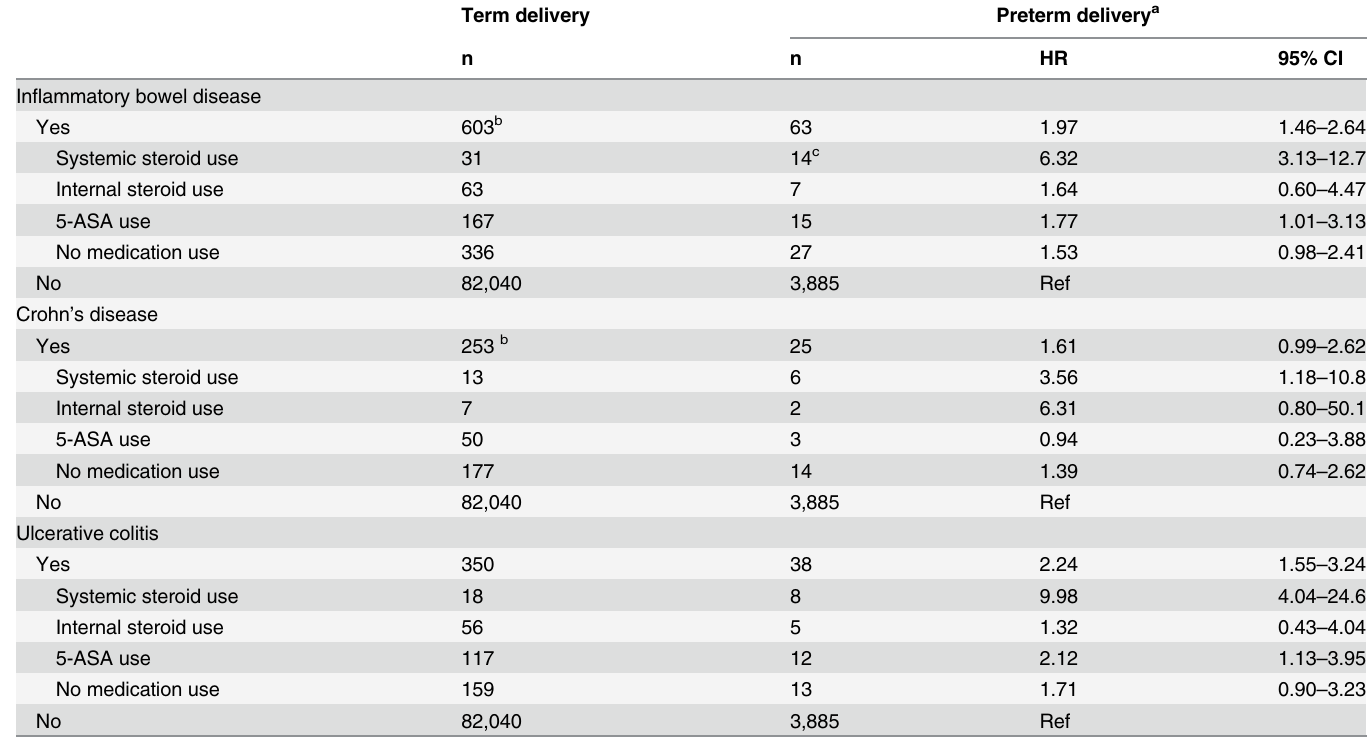
Table 2. Associations between inflammatory bowel disease, medication use during pregnancy and overall rates of preterm delivery in the Danish National Birth Cohort, 1996 –